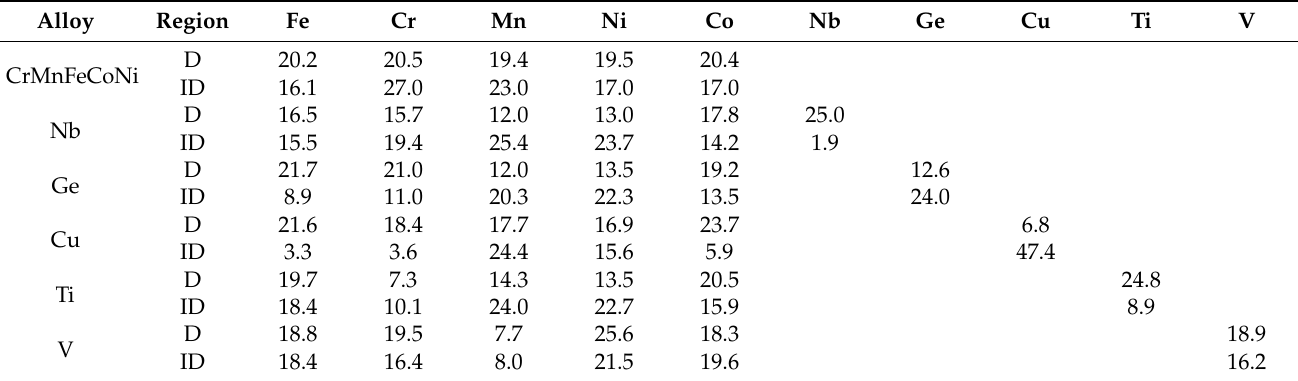
Table A1. Dendritic (D) and interdendritic (ID) compositions (at.%), as listed in Ref. [1].